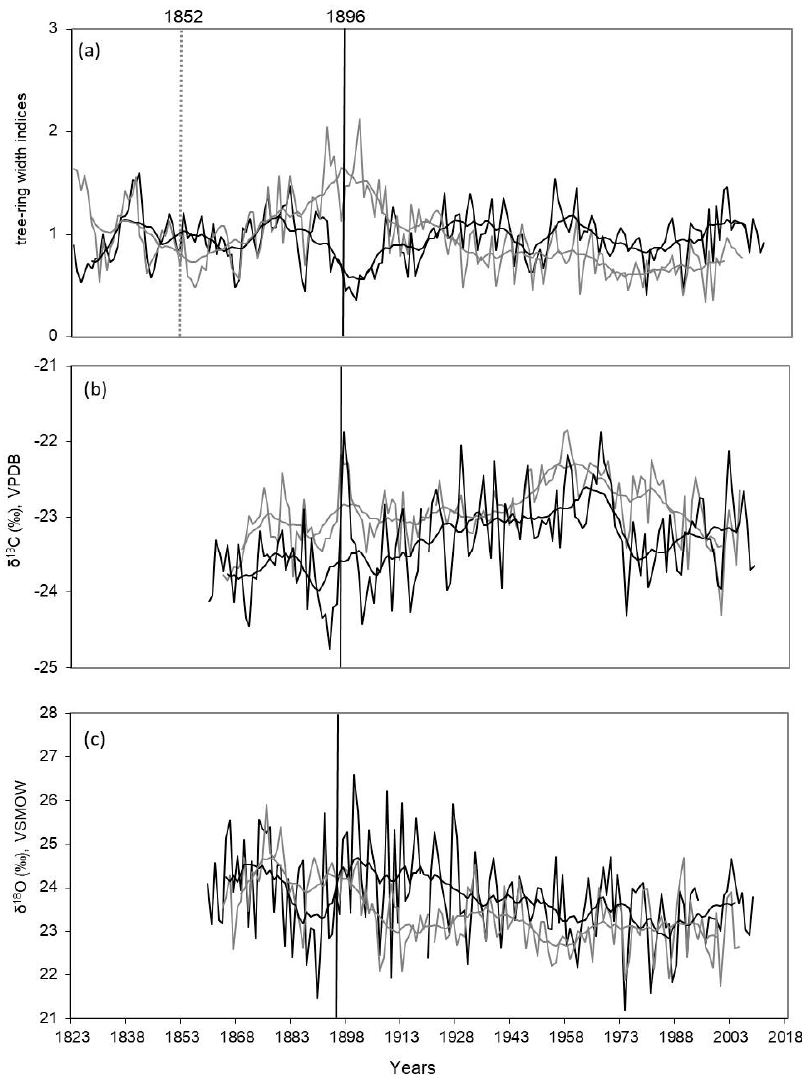
Figure 3. Dynamics of tree-ring width index ( a ), δ 13 C Cell ( b ) and δ 18 O Cell ( c ) chronologies for two comparative sites (black line, DS; grey line, WS) are shown. Smoothed data by a 11—years running means are shown. Vertical black line indicates the date of the fire in 1896 for DS, vertical dotted line indicates the date of the fire in 1852 for WS.